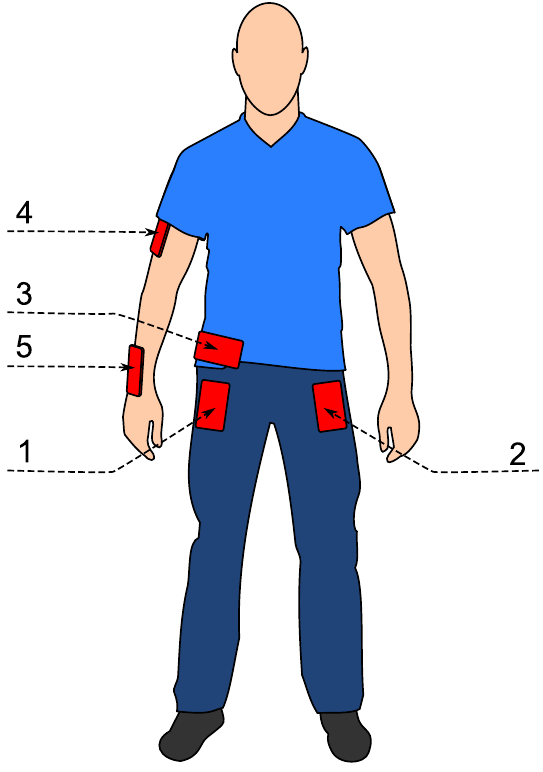
Figure 1. Overview of the phone positions on a